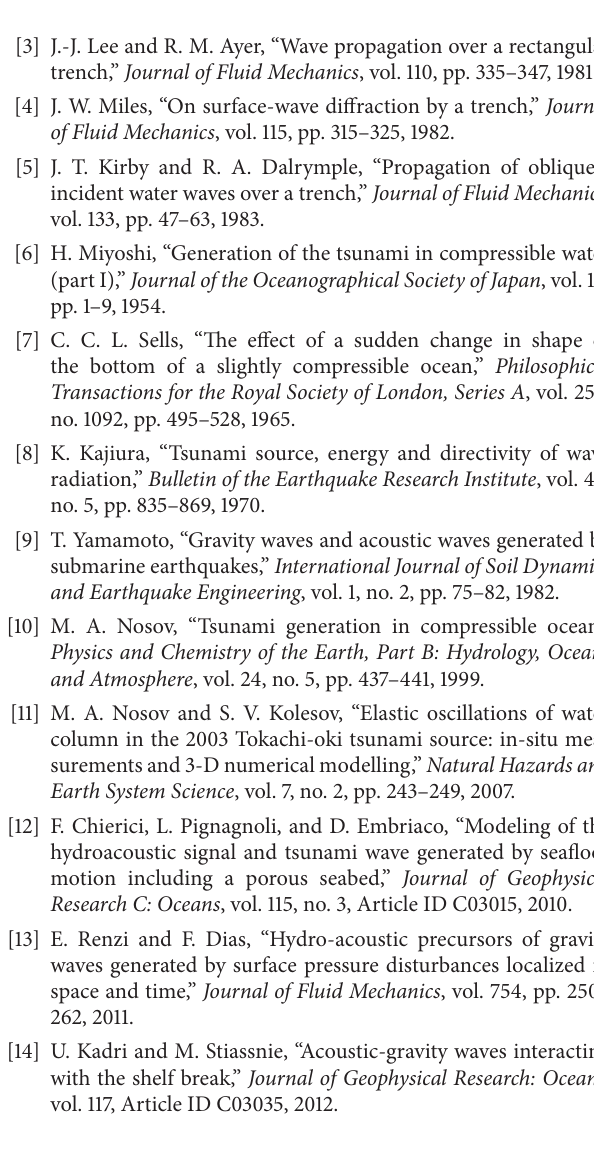
of the trench is shallow enough to prevent the existence of the low acoustic-gravity